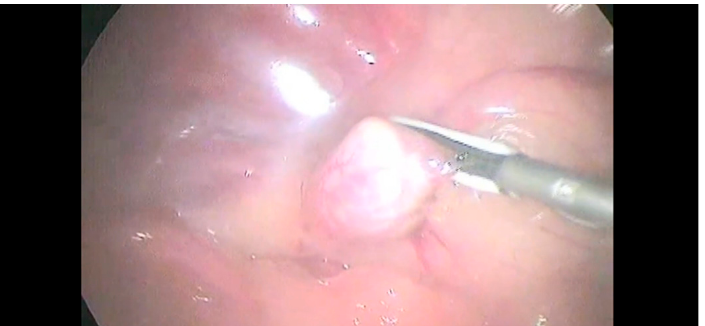
Figure 3. The circumferential dissection of the adrenal gland was achieved using a 5 mm sealing device. On the left side, the dissection started with the blunt incision of the peritoneum over the caudal margin of the tumor using the Kelly forceps or, alternatively, the tip of a vessel sealer. The dissection was continued cranially until the phrenicoabdominal vessel was evident, then, it was sealed and sectioned with LigaSure™ (Figure 4); however, laparoscopic hemoclips (Endo clip II ML, Tyco Health- care, Milano, Italy) were sometimes used in addition to the vessel-sealing device.